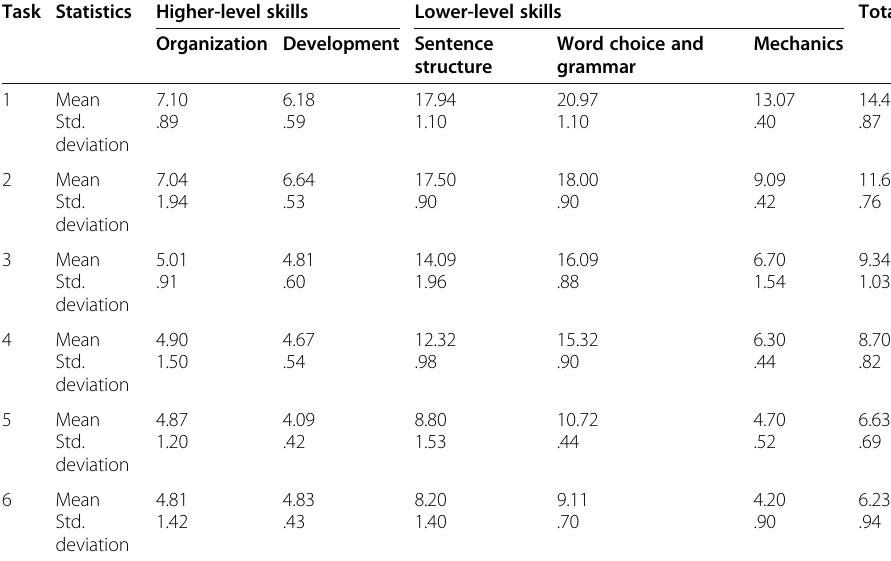
Table 2 Descriptive writing tasks: descriptive statistics Task Statistics Higher-level skills